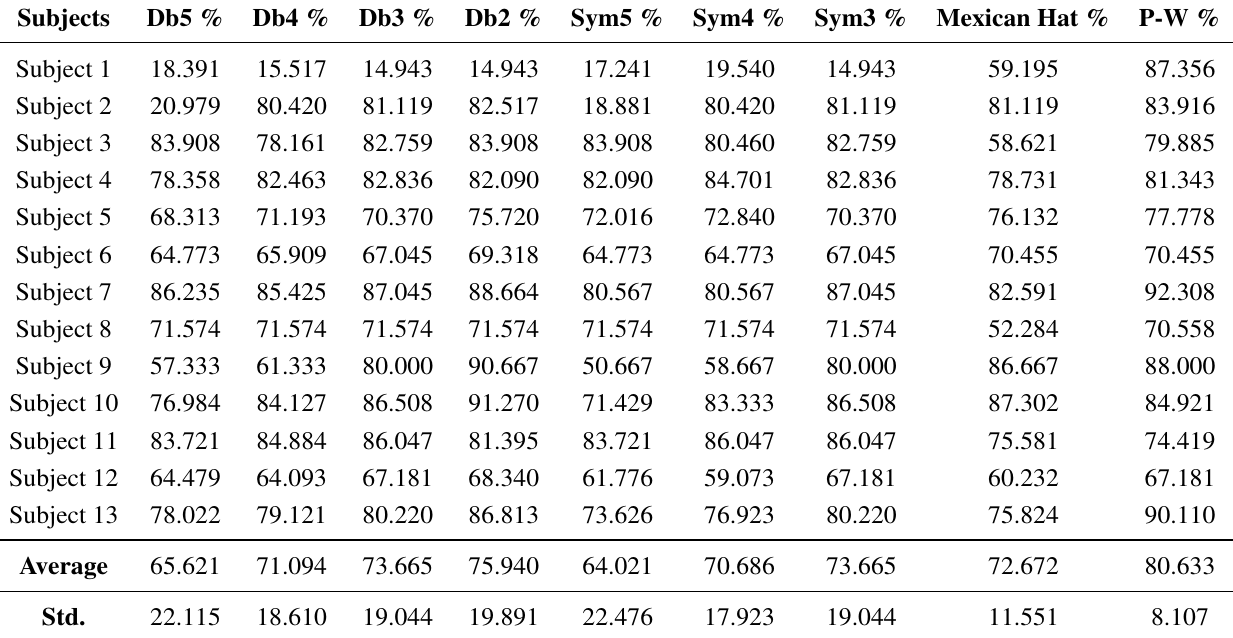
Table 3. Classification Results (P-W = Pseudo-wavelet).